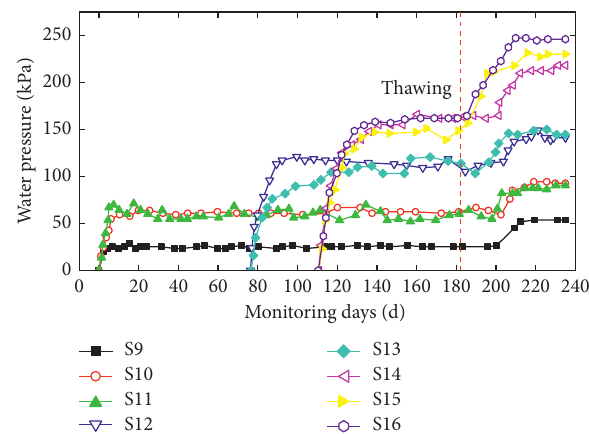
Figure 25: Water pressure outside the tunnel initial